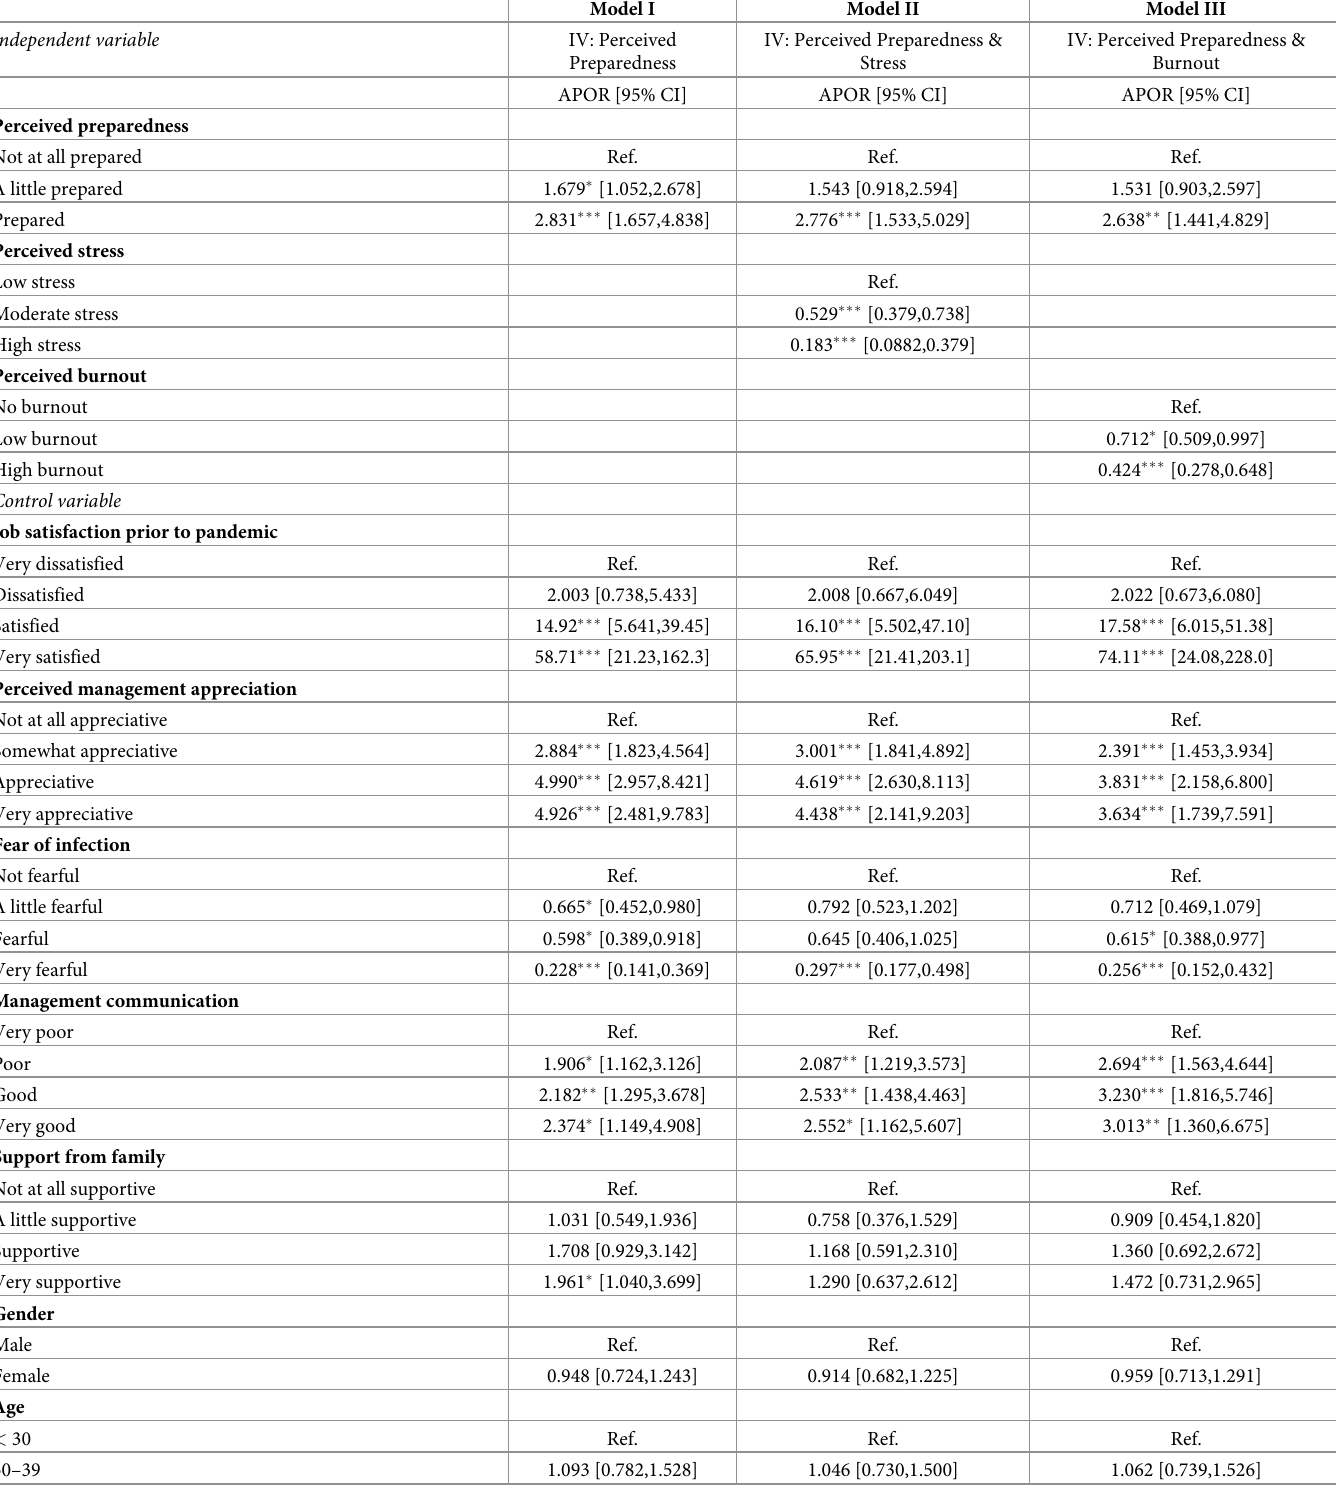
Table 4. Multivariable model showing the association between perceived preparedness and current job satisfaction, controlling for perceived burnout, stress, and other socio-demographic